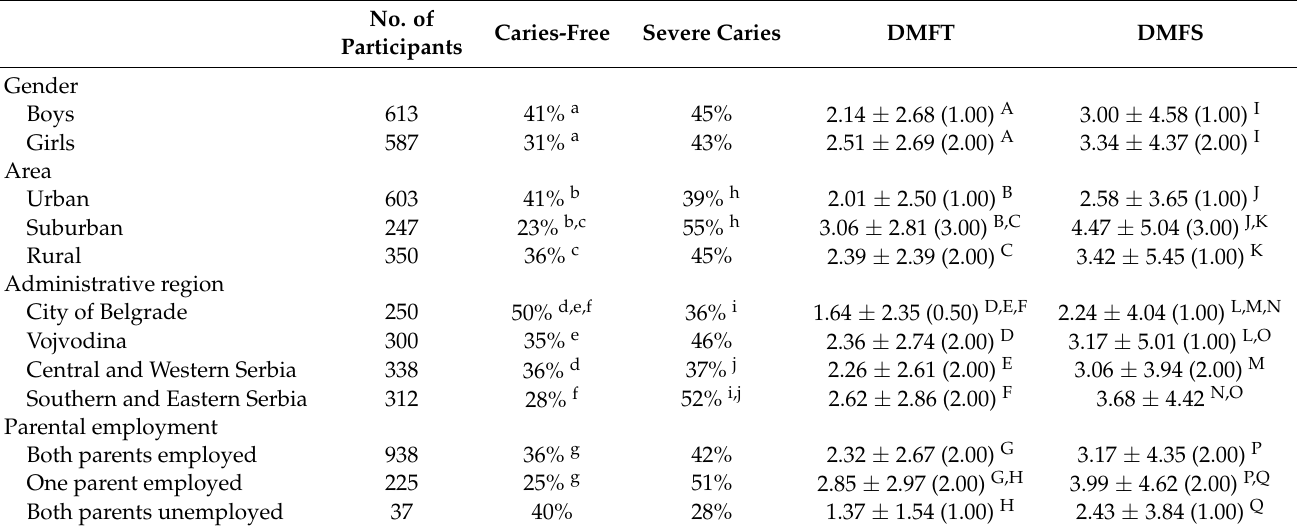
Table 3. Prevalence of caries-free and children with severe caries (%), DMFT and DMFS values (mean ± SD (median)) in 12-year-old children in